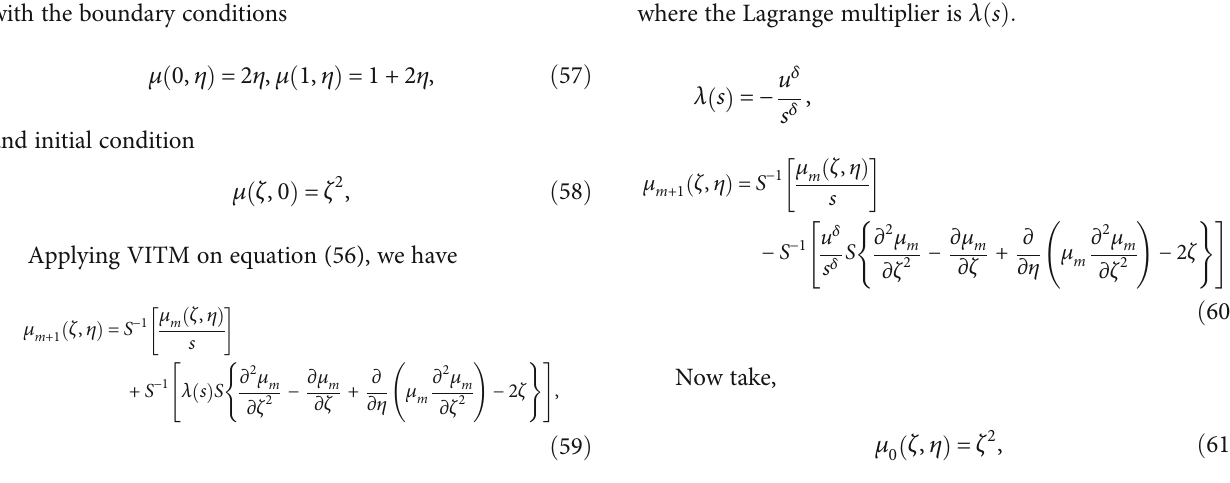
Figure 7: Graph of exact and approximate solutions of Problem